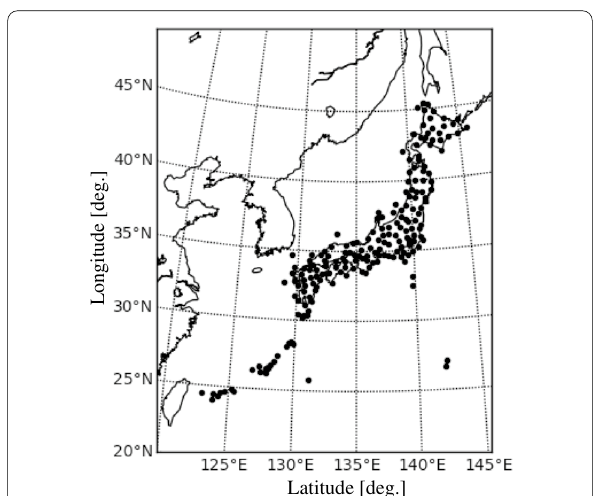
Fig. 1 Distribution of the 200 GEONET stations used in this